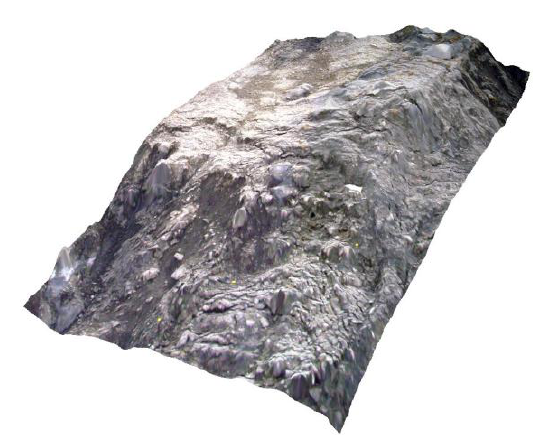
Figure 9. DTM of the upper part of the Super-Sauze landslide in October 2008